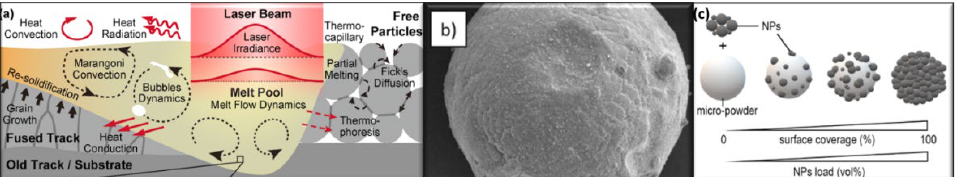
Figure 1. ( a ) Schematic of interactive physical phenomena during a stable LPBF process [2]. ( b ) scanning electron microscopy (SEM) picture of 1.2709 at 10,000× g magnification coated with 1 vol.%